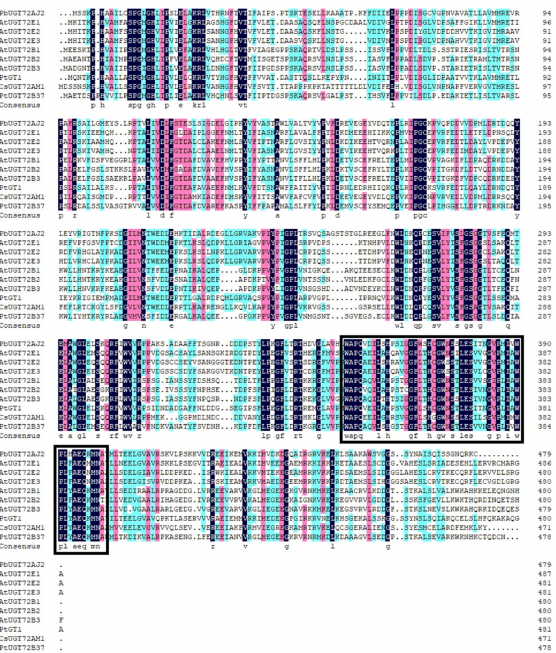
Figure 2. Amino acid sequence alignment of PbUGT72AJ2 and nine homologues. The identified UGTs in the multiple alignment are AtUGT72E1, 2, 3 ( A. thaliana At3g50740, At5g66690, At5g26310); AtUGT72B1, 2, 3 ( A. thaliana At4g01070, At1g01390, At1g01420); Populus tomentosa PGT1 (GenBank: HM776516), Camellia sinensis CsUGT72AM1 (GenBank: KY399734) and Populus trichocarpa UGT72B37 (GenBank: MT181030). The multiple alignment was performed using DNAMAN 7.0 software (LynnonBiosoft, San Ramon, CA, USA). The black rectangle indicates the domains of the PSPG box; Different colors indicate different homology.